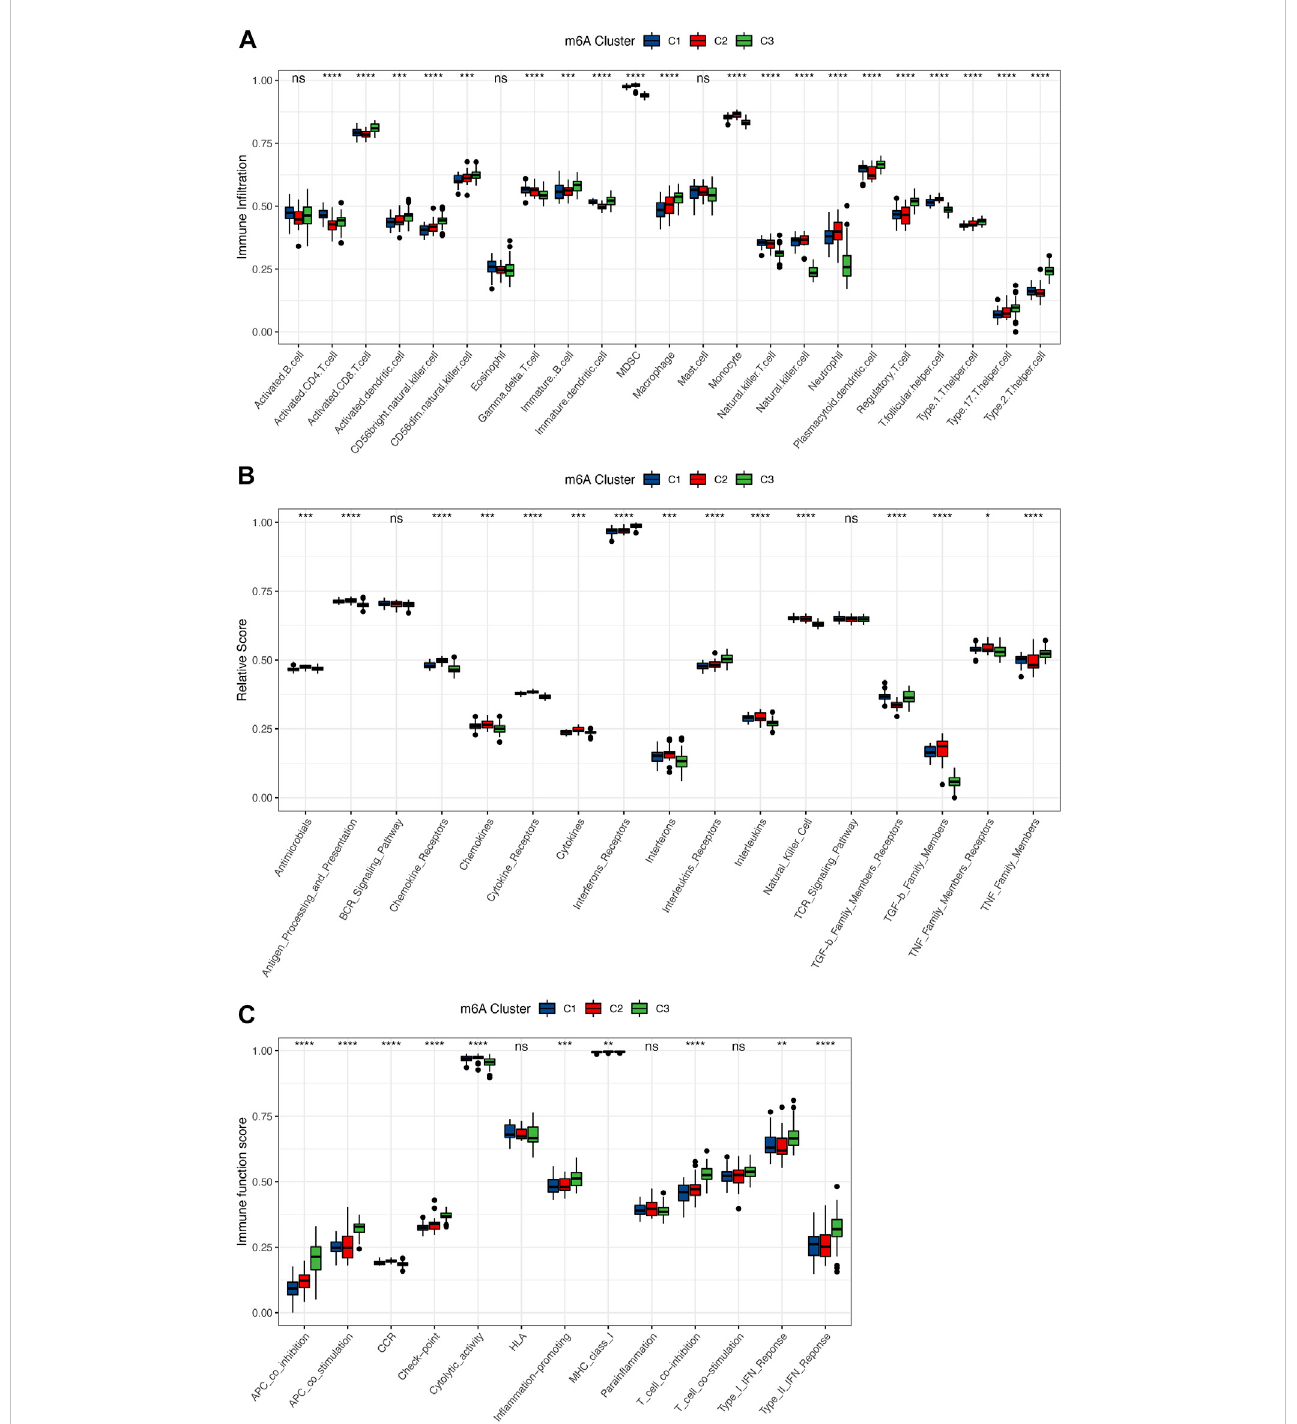
FIGURE 5 Immune microenvironment characteristics among 3 distinct m 6 A subtypes. (A) Differences in the abundance of each immune cell in fi ltration in 3 m 6 A subtypes. (B) Activity differencesofeachimmuneresponsegenesetin3m 6 Asubtypes. (C) Expression differencesofeachimmunefunctiongenesetin3m 6 A subtypes. Above * indicates p < 0.05, ** indicates p < 0.01, *** indicates p < 0.001, **** indicates p < 0.0001, and ns indicates that the difference was not statistically signi fi